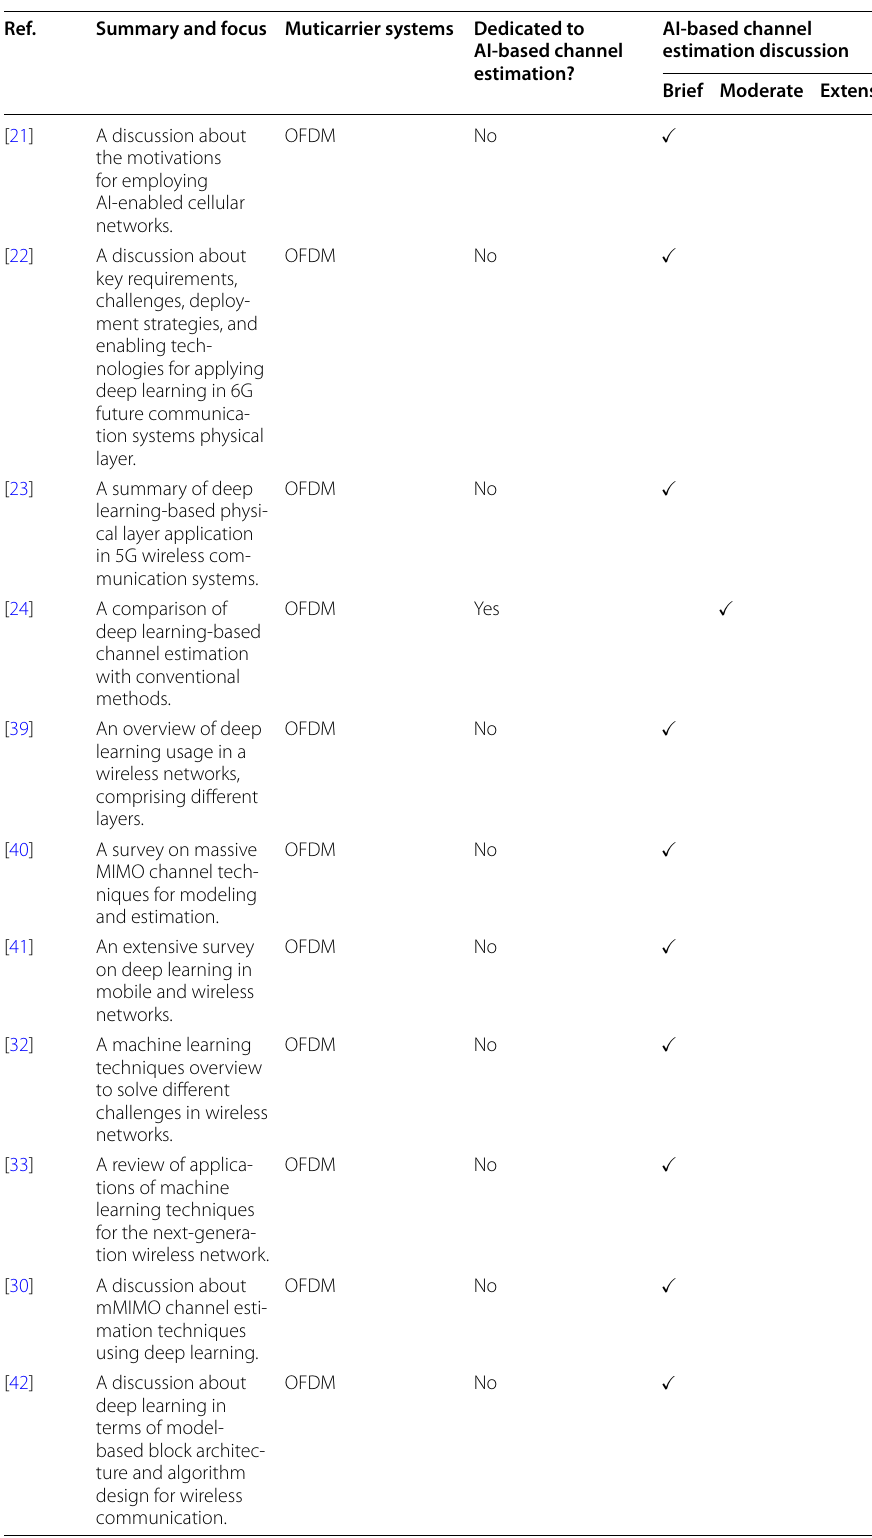
Table 1 Summary of existing surveys, magazines, and review papers related to artificial intelligence for channel estimation in multicarrier systems